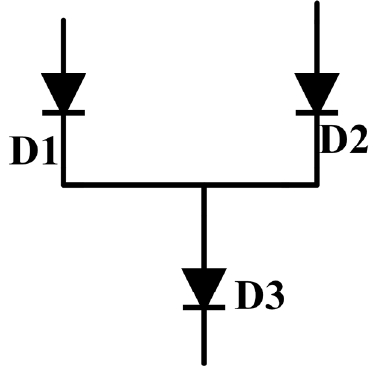
Figure 3. The connection method of diodes, the current of D3 is the sum of the current of D1 and the current of D2.